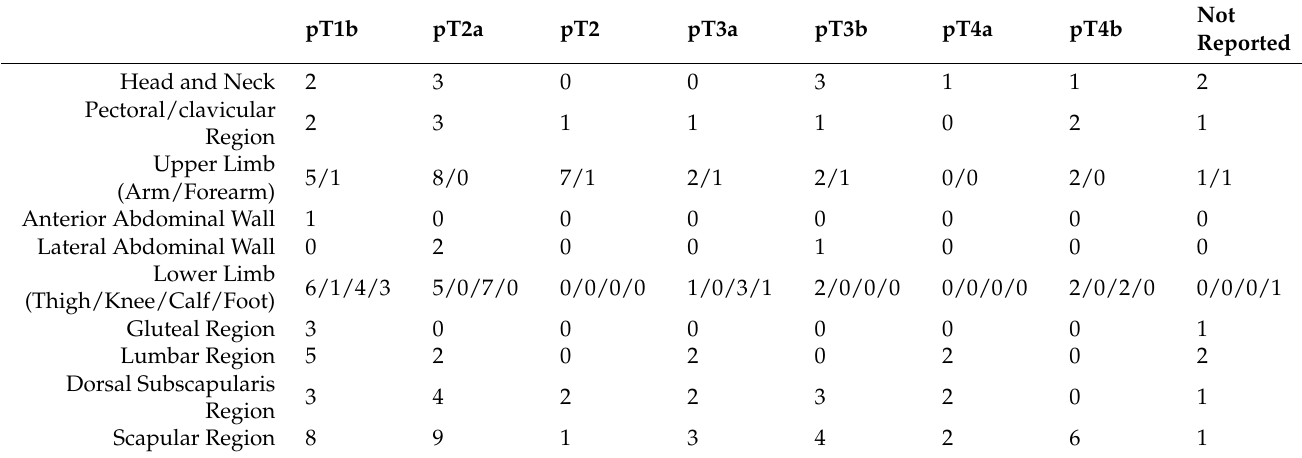
Figure 3. Lymphatic drainage of “Homogeneous drainage group” melanomas. Table 3. pT classification of reported melanomas.